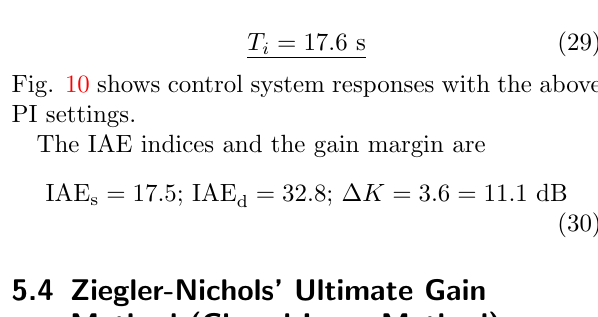
Figure 10: H¨agglund-˚Astrøm’s Robust tuning method: Closed-loop responses.